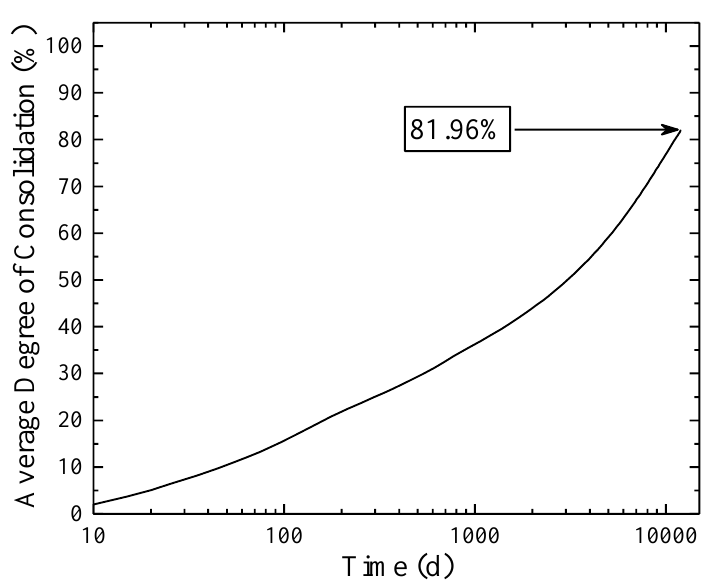
Figure 8. The variation of average degree of consolidation along time.